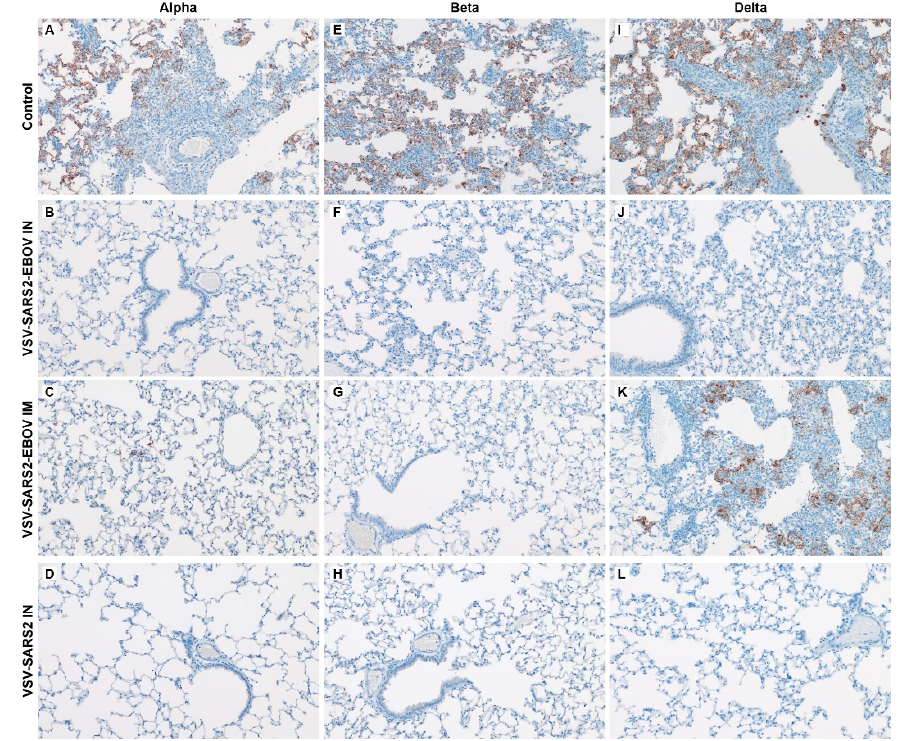
Figure 2. Immunohistochemistry of hamster lungs. Hamsters were vaccinated IM or IN 28 days prior to IN challenge with SARS-CoV-2 Alpha ( A – D ), Beta ( E – H ), and Delta ( I – L ) VOC. At 4 DPC lung samples were collected and stained with anti-SARS-CoV-2 nucleocapsid antibody (200×). Antigen immunoreactivity was readily detected in all control hamsters regardless of the challenge variant ( A , E , I ). Antigens were not detected in any VSV-SARS2-EBOV or VSV-SARS2 IN-vaccinated hamster regardless of challenge variant ( B , D , F , H , J , L ). Antigen immunoreactivity was observed only in pulmonary macrophages of VSV-SARS2-EBOV IM-vaccinated hamsters challenged with the Alpha VOC ( C ). No immunoreactivity was observed in VSV-SARS2-EBOV IM-vaccinated, Beta VOC-challenged hamsters ( G ). Abundant immunoreactivity was observed in VSV-SARS2-EBOV IM-vaccinated, Delta VOC-challenged hamsters ( K ).